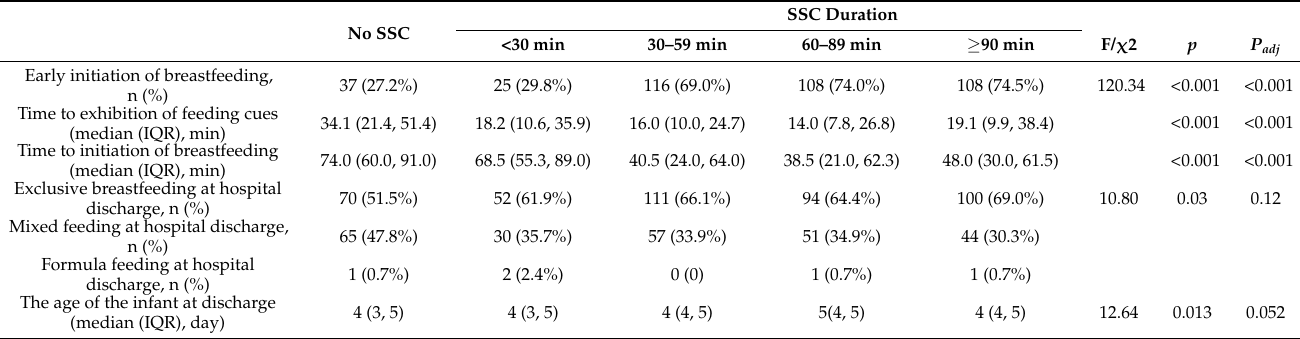
Table 2. Breastfeeding outcomes according to different SSC durations after